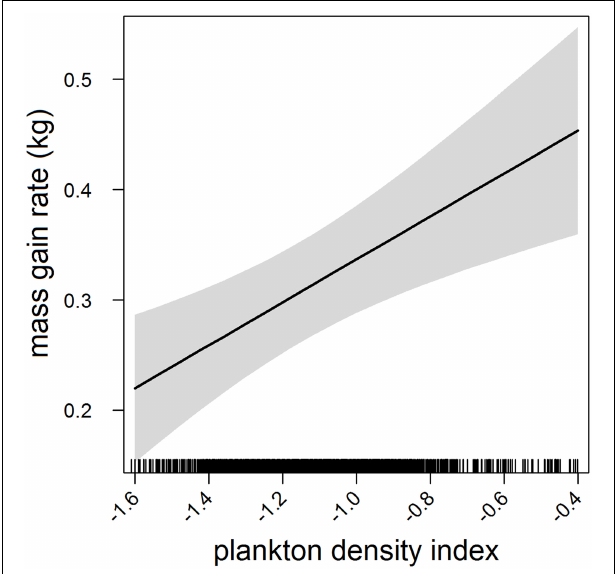
FIGURE 2 | Effects plot of the relationship between plankton densities encountered by seals (i.e., PDI) and their foraging success (i.e., mass gain rate) from our mixed model analysis. Shaded area indicates the confidence